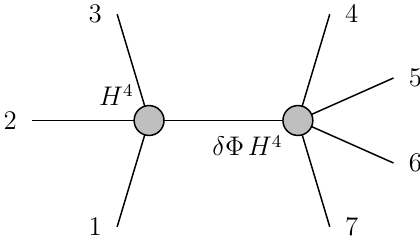
Figure 2 . Factorization of a 7-point amplitude though a pair of 4-derivative